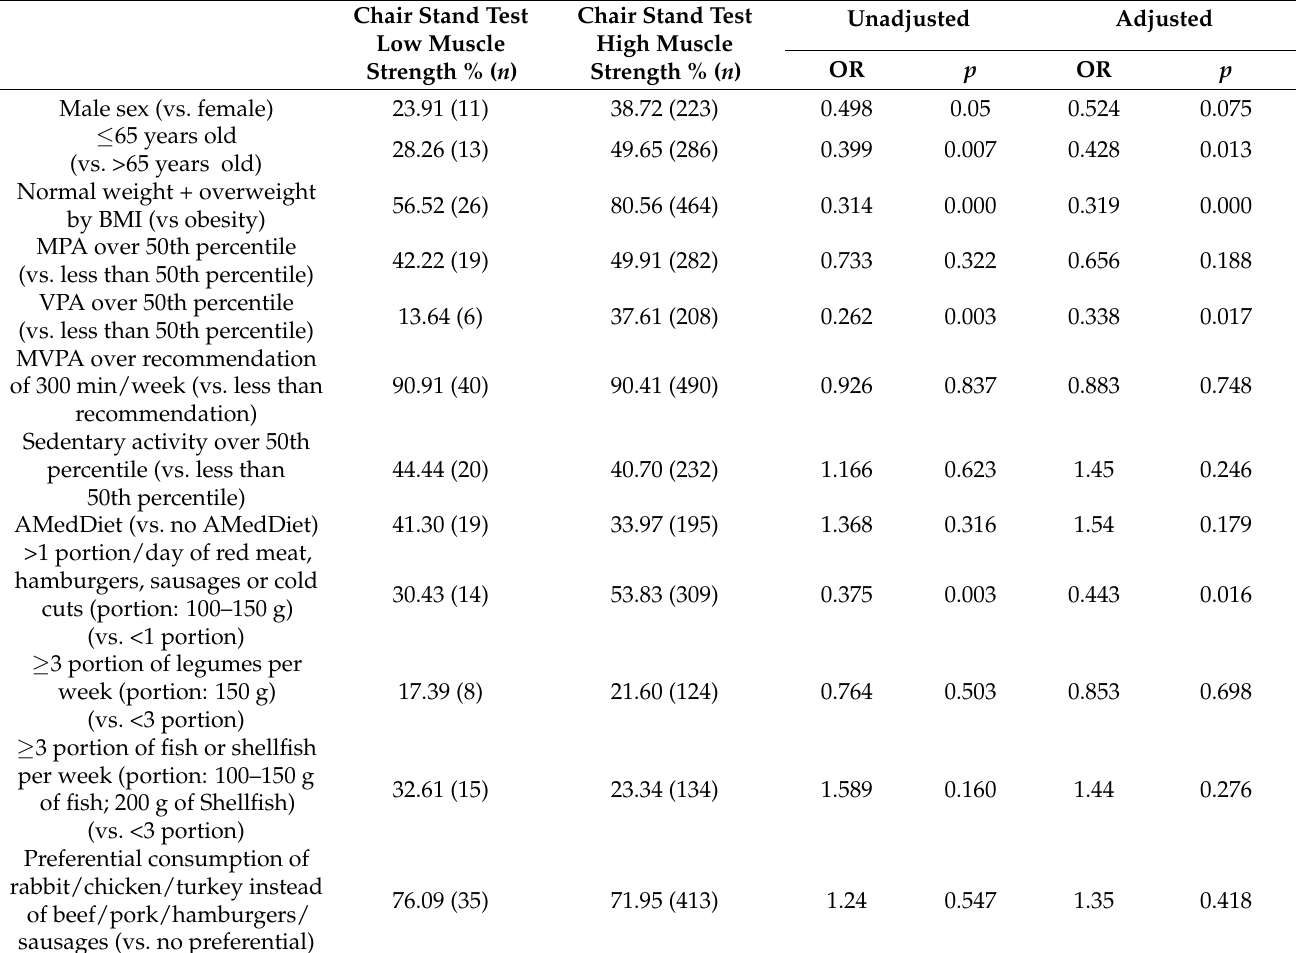
Table 4. Odds ratio of muscle strength by chair stand test unadjusted and adjusted by sex and age. Chair Stand